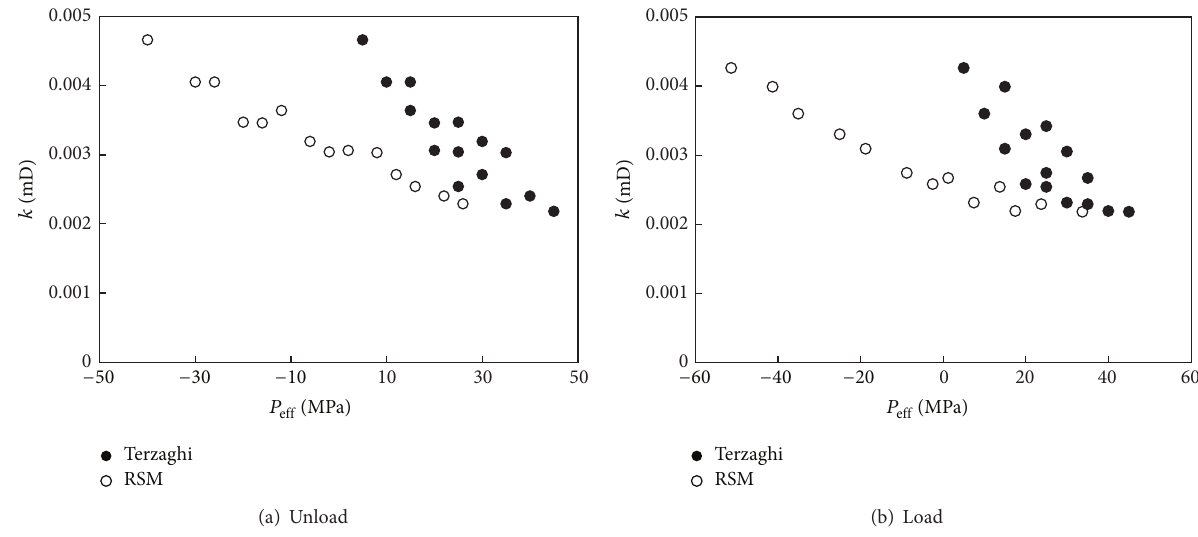
Figure 11: Permeability versus effective pressure under distilled water condition during pore pressure unloading (a)/loading (b) processes.